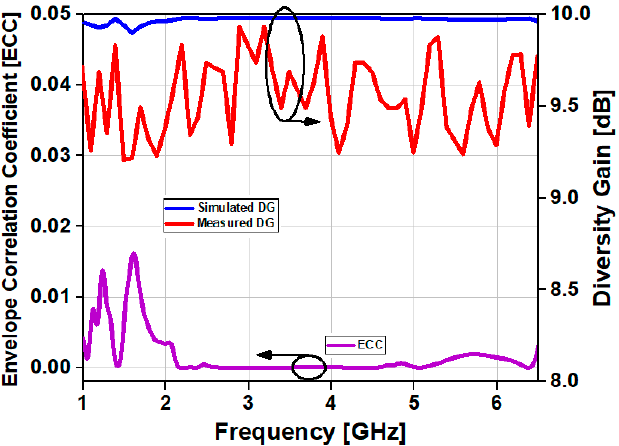
Figure 12. Shows the proposed design's ECC and diversity